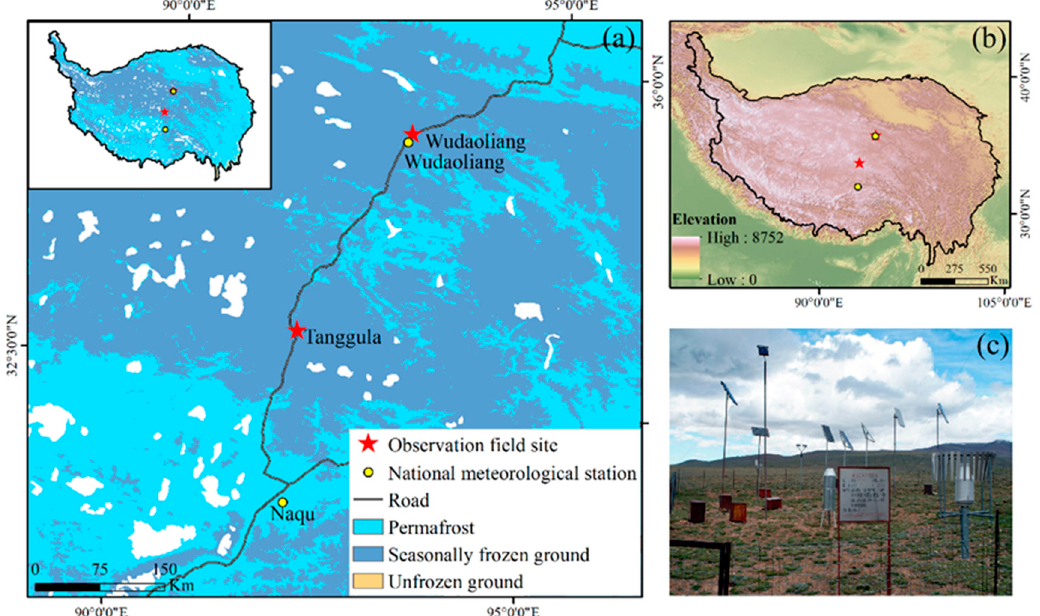
Figure 1. Location and topography of the study area. ( a ) Location of observation sites and spatial distribution of permafrost. ( b ) Topography of the Qinghai–Tibet Plateau. ( c ) Photograph of observation devices at the Tanggula comprehensive observation field site.